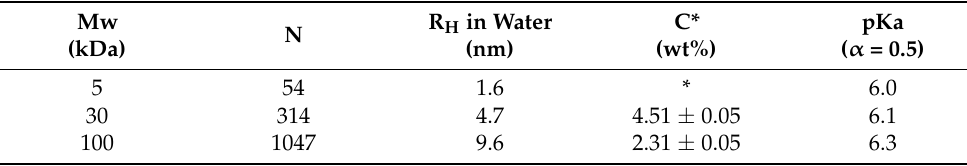
Table 1. Polyacrylic acid properties in salt-free solutions [37–39].